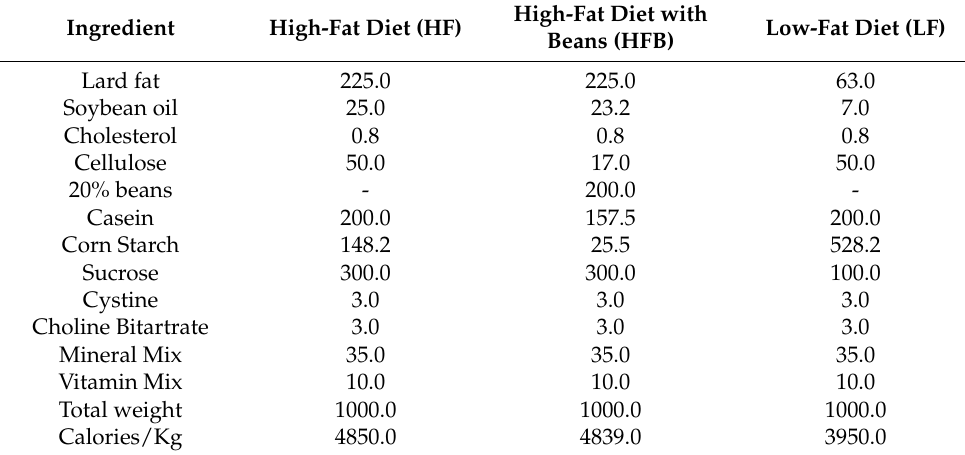
Table 1. Diet compositions